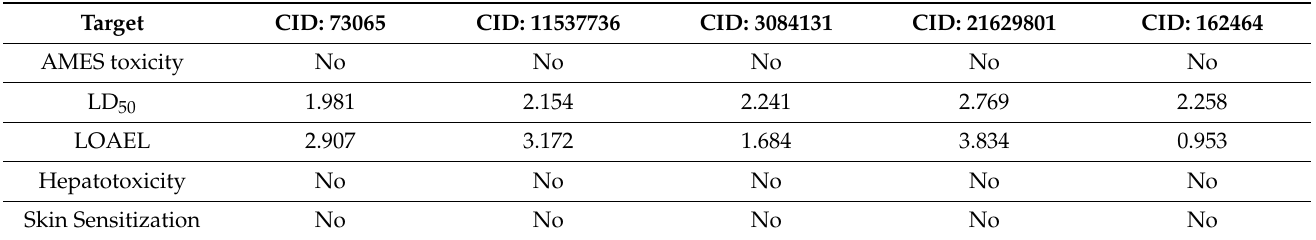
Table 3. A list of the drug-induced toxicity profile for the five selected natural